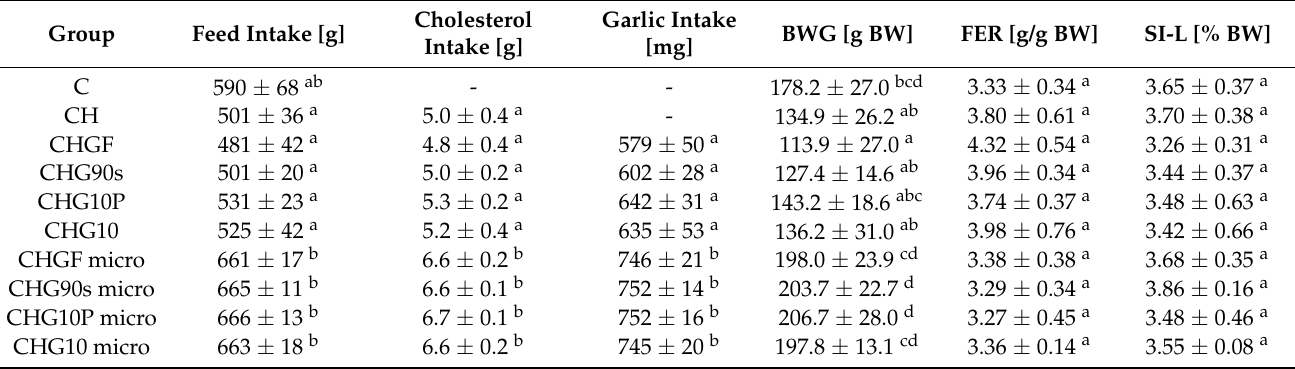
Table 4. Influence of freeze-dried fresh and thermally processed garlic on performance: body weight gain, FER and somatic index of liver (SI-L) in rats fed control- and cholesterol-containing (1% of cholesterol) diet during the 28 day